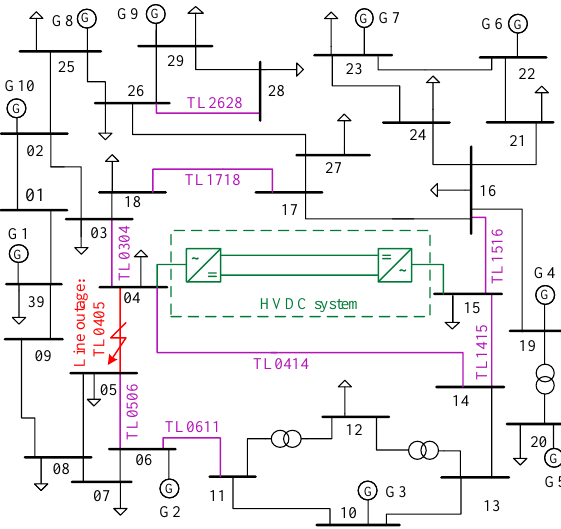
Fig. 3. Modified IEEE 39-bus system with HVDC